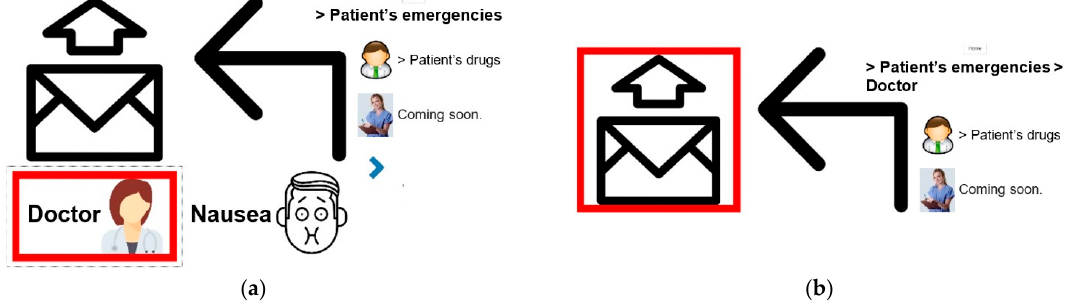
Figure 6. Patient WEB Application for communication using switch-based or eye-tracking-based patient’s needs detection. (Patient device screen: Laptop; Caretaker device screen: Smartphone; raw eye image provided by the IR video camera).